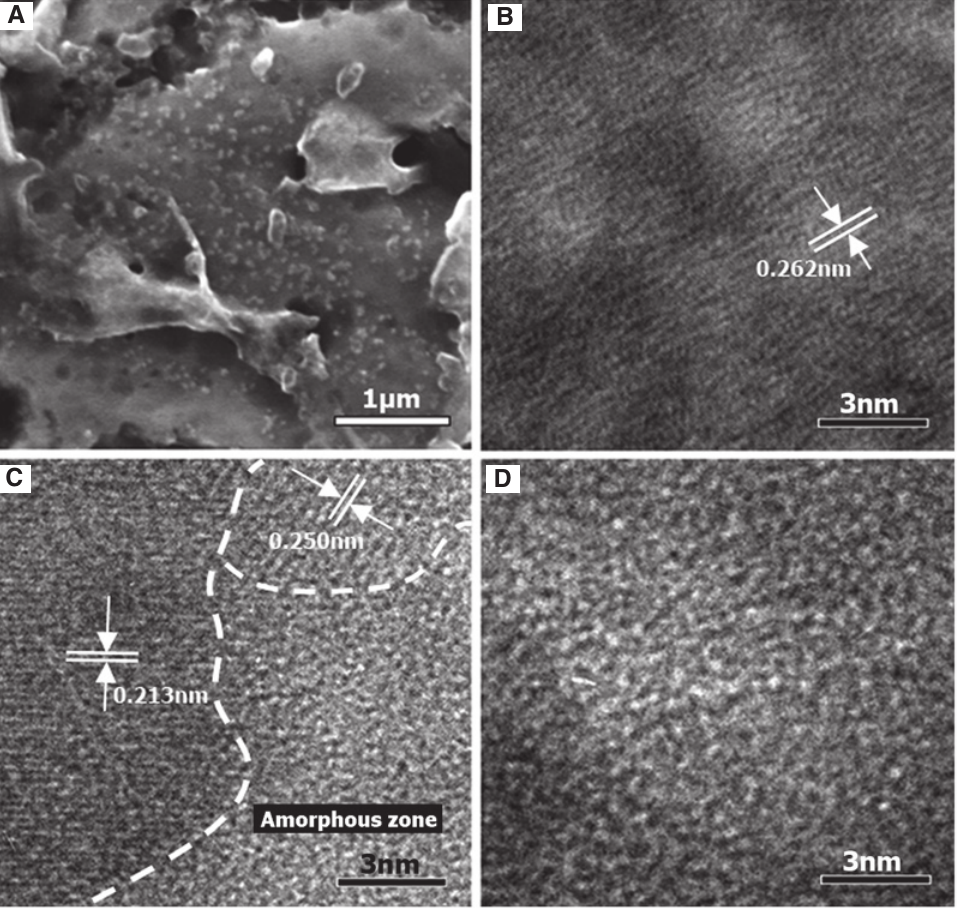
(B), TiN and Ti Al (C), and the amorphous 2 3